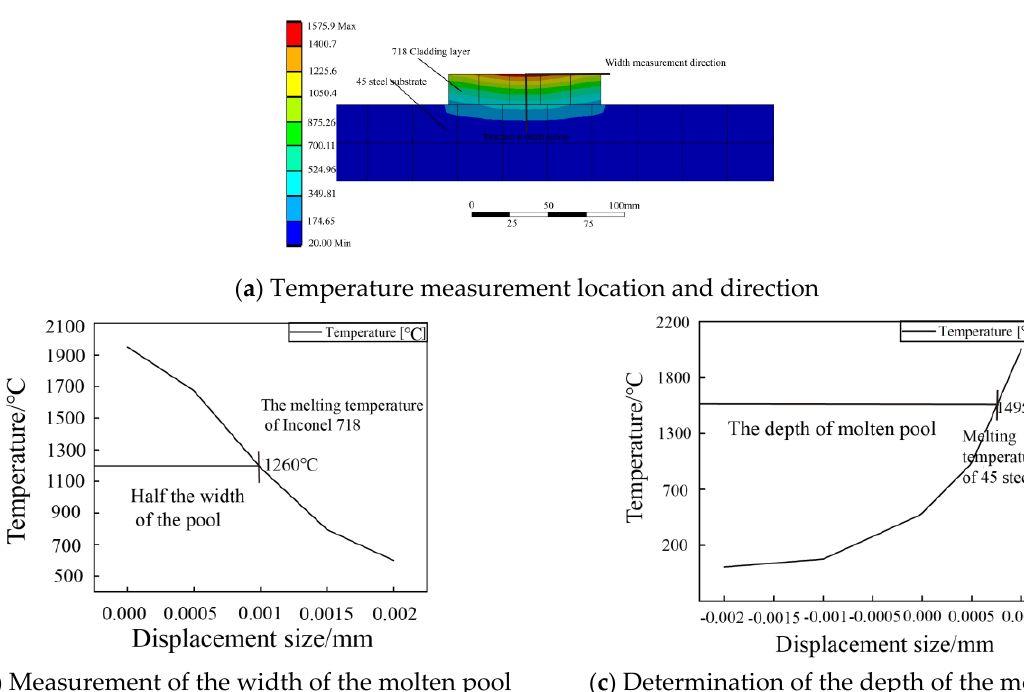
Figure 8. Schematic diagram of temperature measurement.